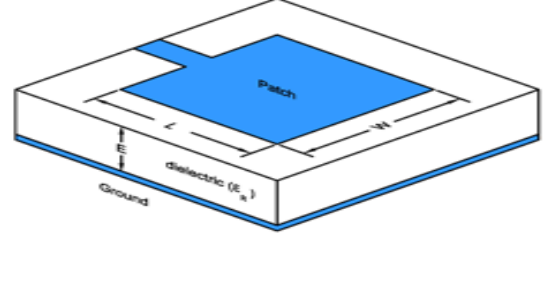
Figure 1. Structure of Patch antenna